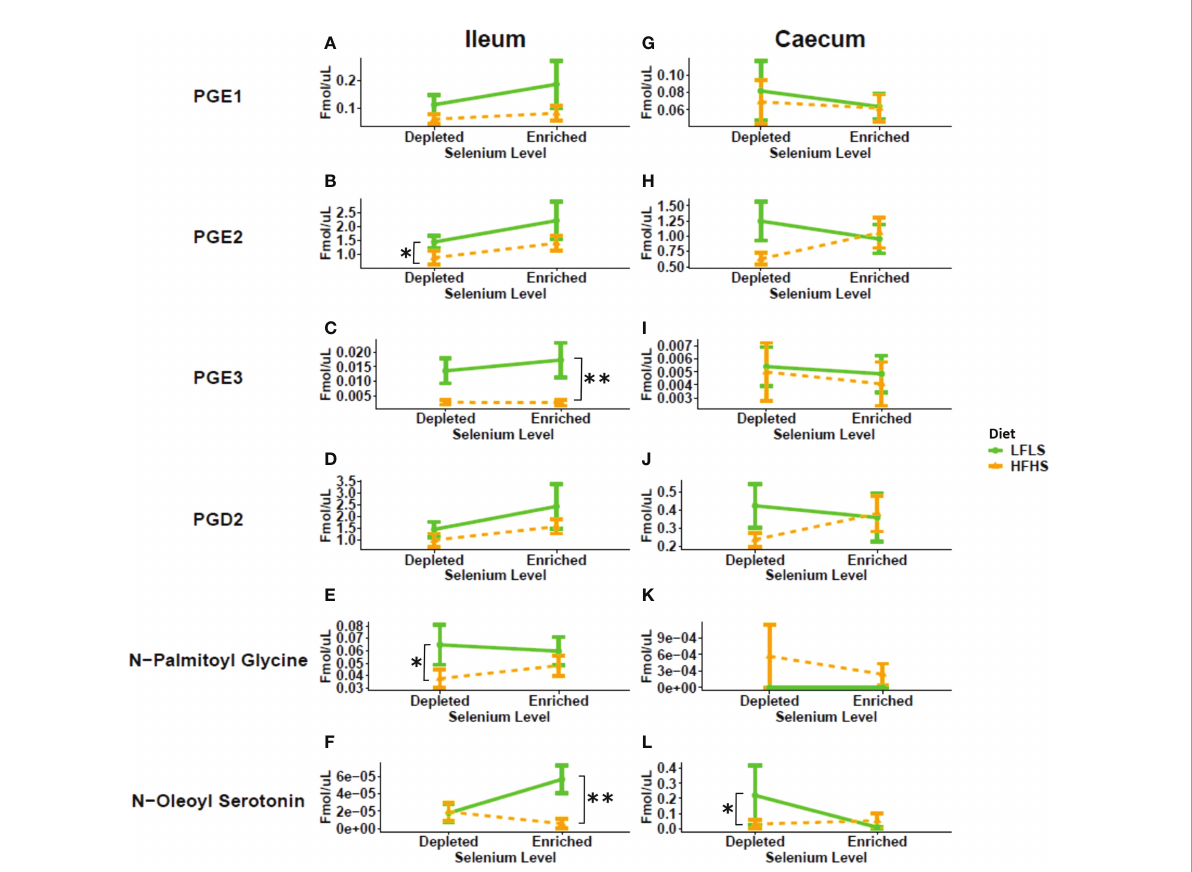
FIGURE 4 Response of prostaglandins and additional eCBome mediators in Se-enriched and Se-depleted LFLS or HFHS diets in the intestine. Line chart representation of the eCBome mediators in Ileum (A-F) and Caecum (G-L) . Data are expressed as the mean ± SEM (n=12). P values of linear contrast analysis are detailed when signi fi cant ‘ ** ’ , P < 0.01, ‘ * ’ , P<0.05 using contrast test between enriched and depleted Se levels, LFLS and HFHS formulations and the combination between Se levels and formulations. The samples were analysed at day 28 of the